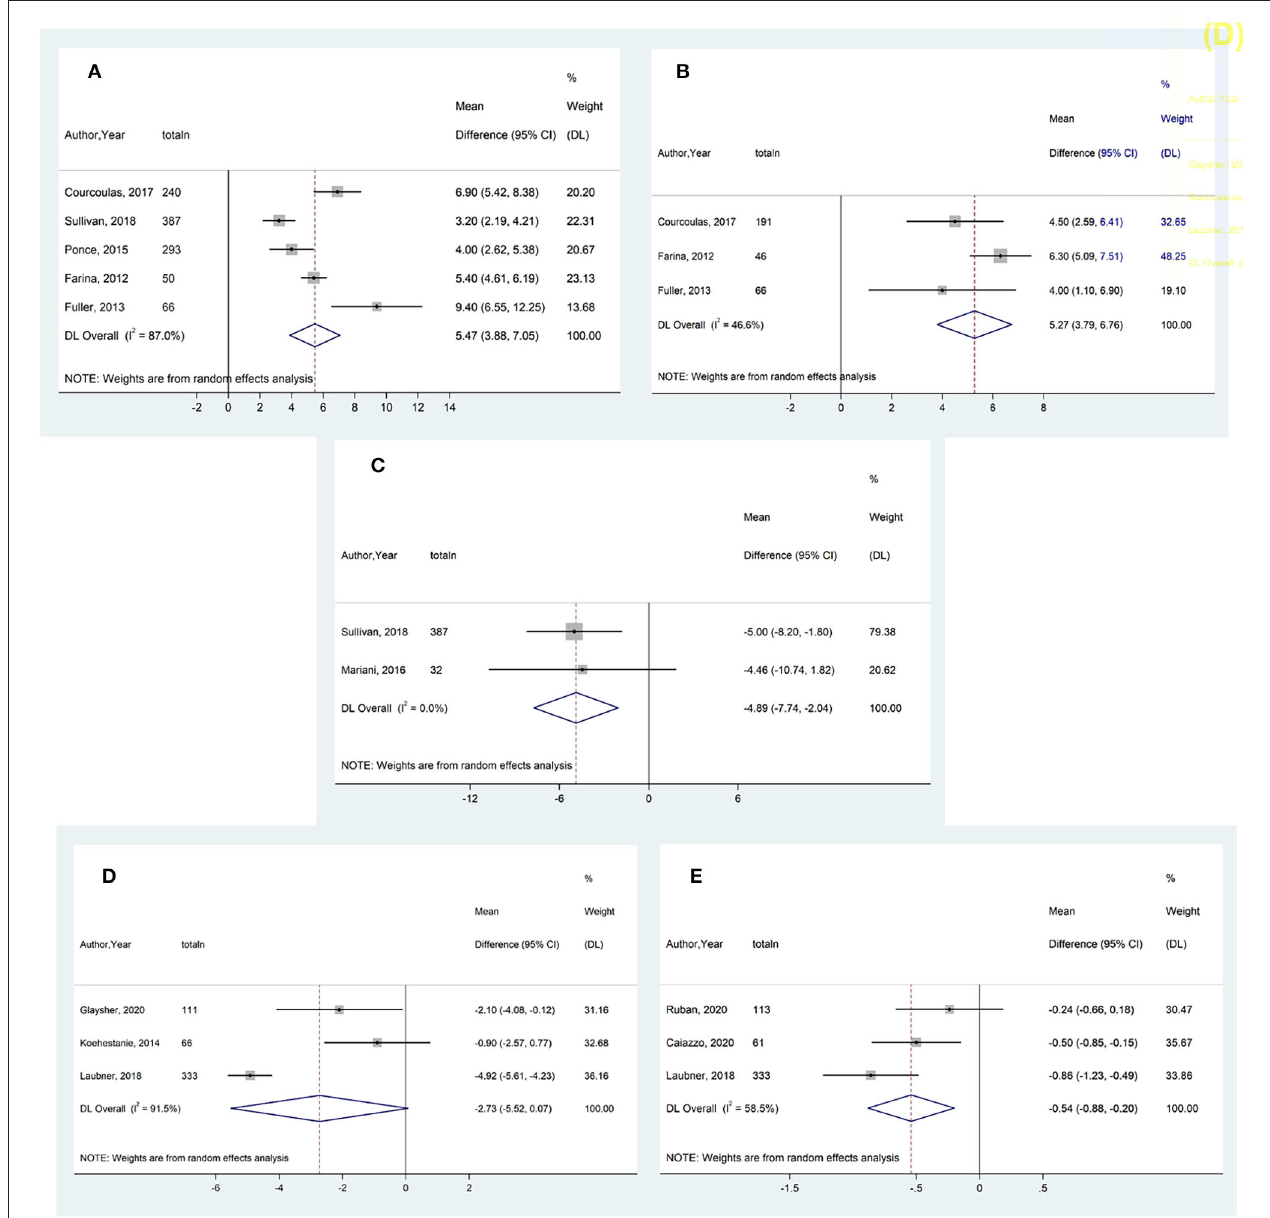
FIGURE 2 | Weighted mean difference of (A) percentage total body weight loss (%TBWL) between IGB and SMT groups at 6 months, (B) %TBWL between IGB and SMT groups at 12 months, (C) reduction in fasting plasma glucose (mg/dL) between IGB and SMT groups at 6 months, (D) reduction in body mass index (kg/m 2 ) between DJBL and SMT groups at 12 months, (E) reduction in percentage of glycated hemoglobin (%HbA1c) between DJBL and SMT groups at 12 months.